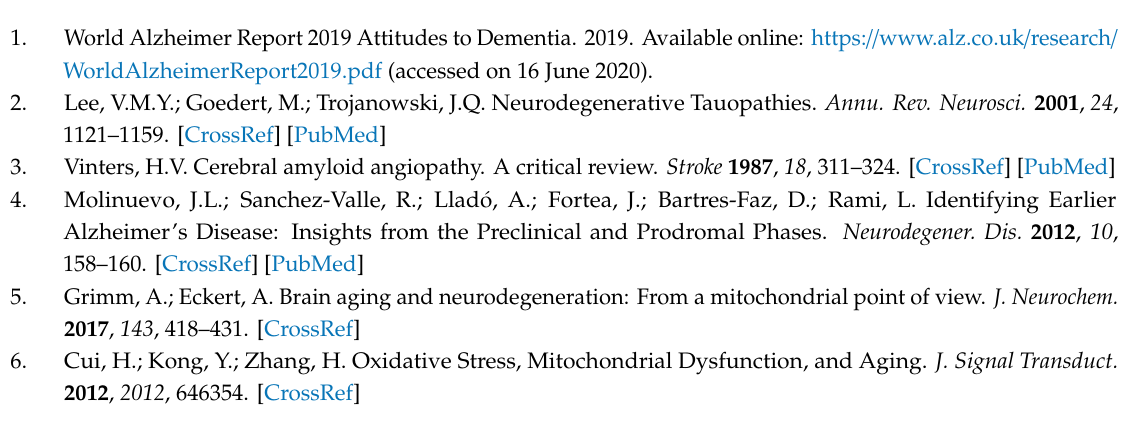
Table SI1 containing PAMPA model control compounds, Table SI2 showing toxicological evaluation, full methodological description including chemical synthetic protocols, pharmacological experiments and images of the 1 H and 13 C NMR spectra images, Figures SI1 and SI2 showing molecular docking experiments of reference